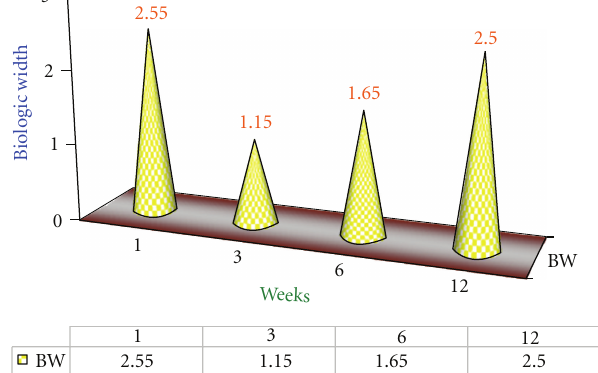
Figure 2: Mean biologic width values of B1 Group at various intervals of